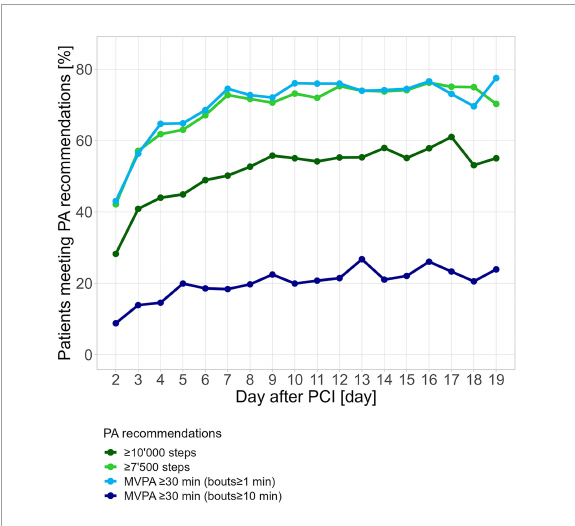
FIGURE2 Percentage of participants reaching various criteria for PA after hospital discharge for PCI. PCI was performed on day 0. Fulfillment of PA criteria was calculated for each participant and each day